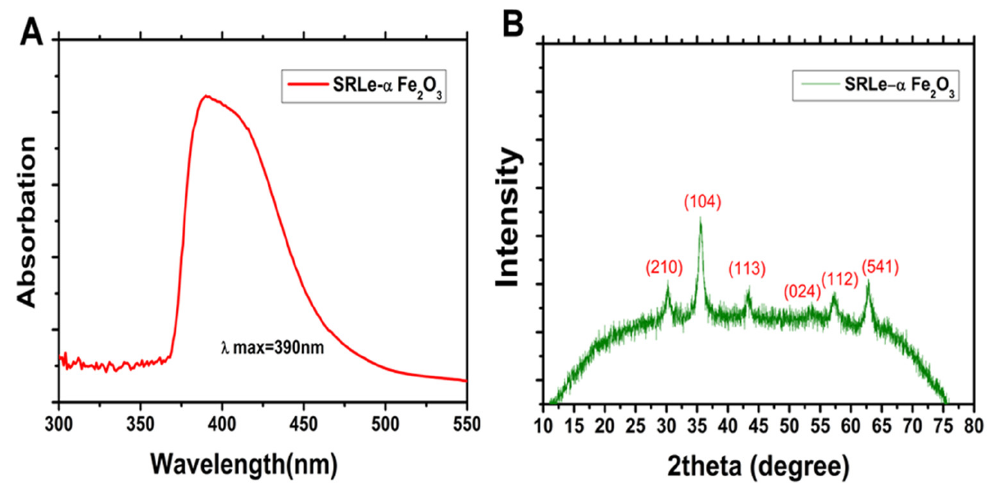
Figure 7. ( A ) UV/visible absorption spectra; ( B ) XRD analysis of SRLe - α Fe 2 O 3 NPs .